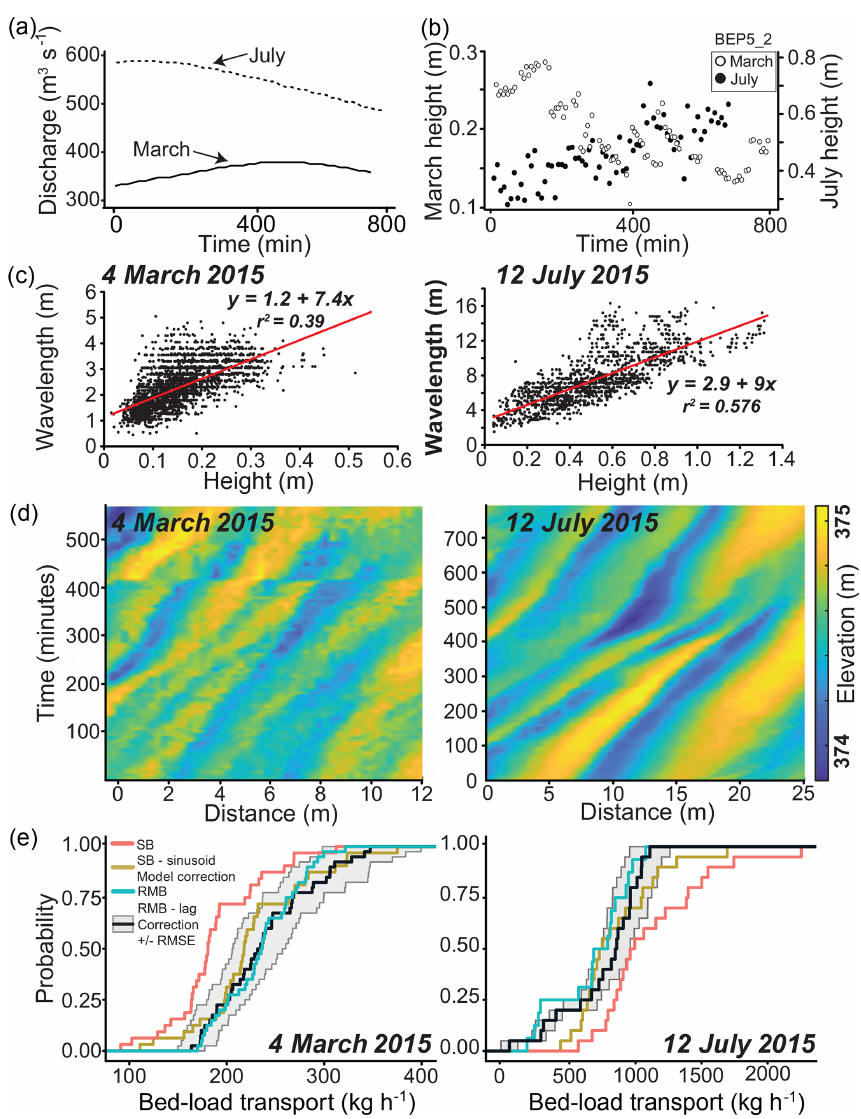
Figure 2. (a) Discharge during the sample time period. Dashed line is July data; solid line is March data. (b) Example of bedform height varying with time from a single BEP. Open circles indicate July data; closed circles indicate March data. (c) Wavelength versus height. Red line indicates linear regression of the data. (d) Space–time plots of bedform evolution. (e) Cumulative density plots of single-beam (SB; red line) and repeat multibeam (RMB; teal line) bed-load transport estimates with added corrections for mischaracterized lag (repeat multibeam; black line with gray area indicated root-mean-square error) and period (single beam; yellow